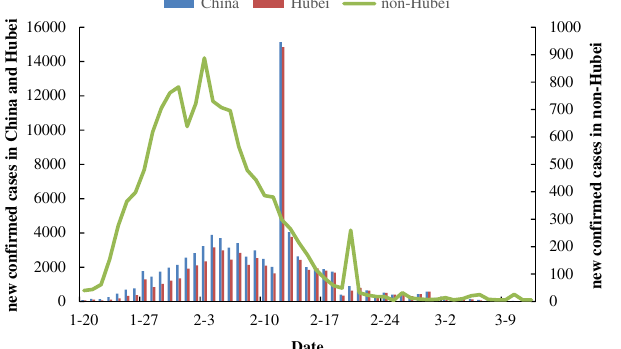
Figure 1. The trend chart of new confirmed cases in China, Hubei and non-Hubei provinces.